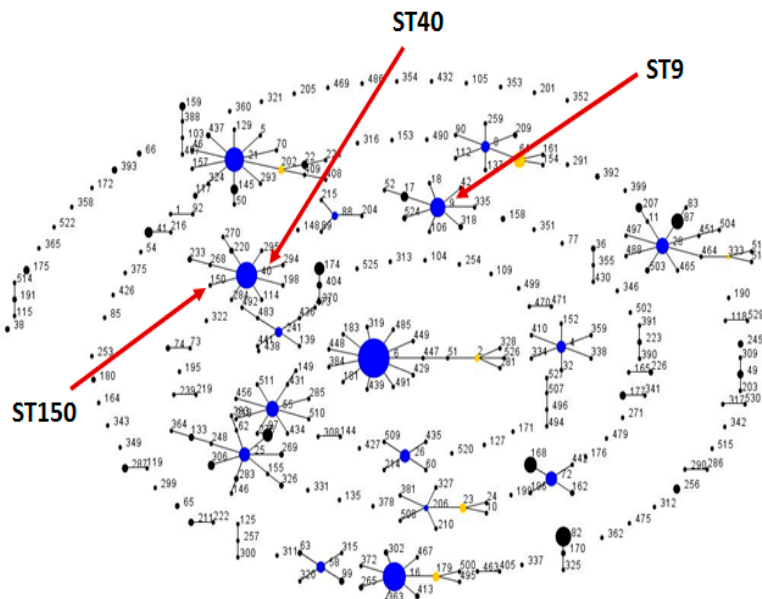
Figure 1. Population snapshot of Escherichia faecalis with the entire multilocus sequencing typing (MLST) database in a single eBURST diagram. STs differing in one allele are connected. Colours indicate predicted primary (blue) and secondary (yellow) founders. The areas of each of the circles indicate the prevalence of the ST in the input data. STs 9, 40 and 150 are marked by arrows. Table 2. Number of copies of 12B3-5 r16S V3-V5 sequence (in brackets) with respect to total E. faecalis